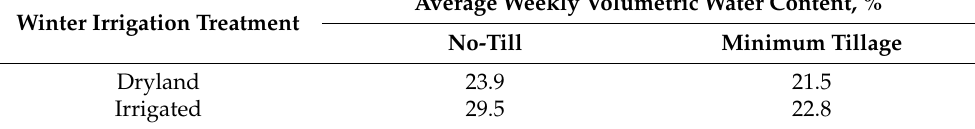
Table 4. Differences in average weekly volumetric water content measured at 20 cm soil depth under different winter irrigation regimes.